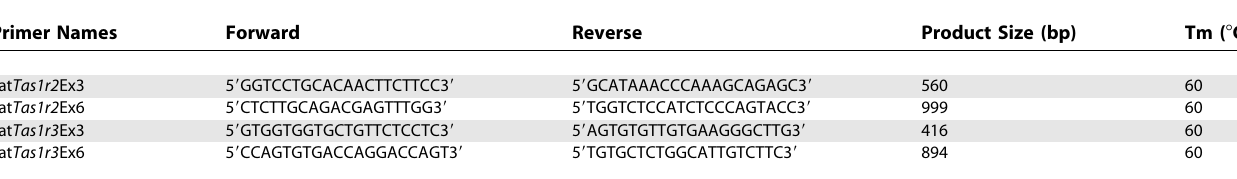
Table 3. Primers for In Situ Probes Primer